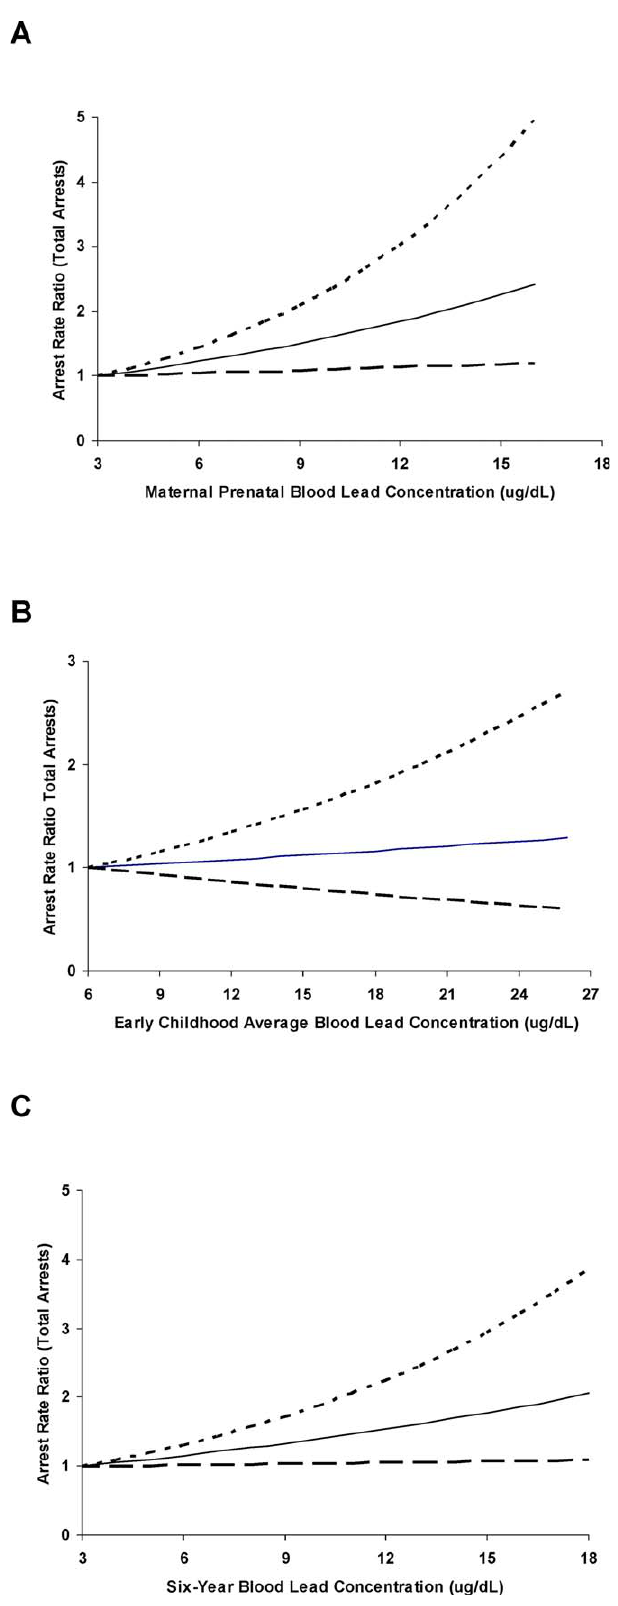
Figure 1. Adjusted Relationship between Blood Lead Concentration and Arrest Rate Ratio For Total Arrests Shown are data for maternal prenatal blood lead concentration (A), early childhood average blood lead concentration (B), and 6-year blood